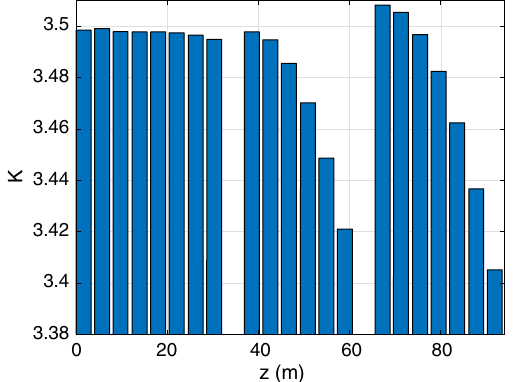
FIG. 15. The undulator strength parameter K used in the single- dechirper setup. The undulator strengths of first four undulator segments in the first undulator section are the same as the ones used in Ref. [11].